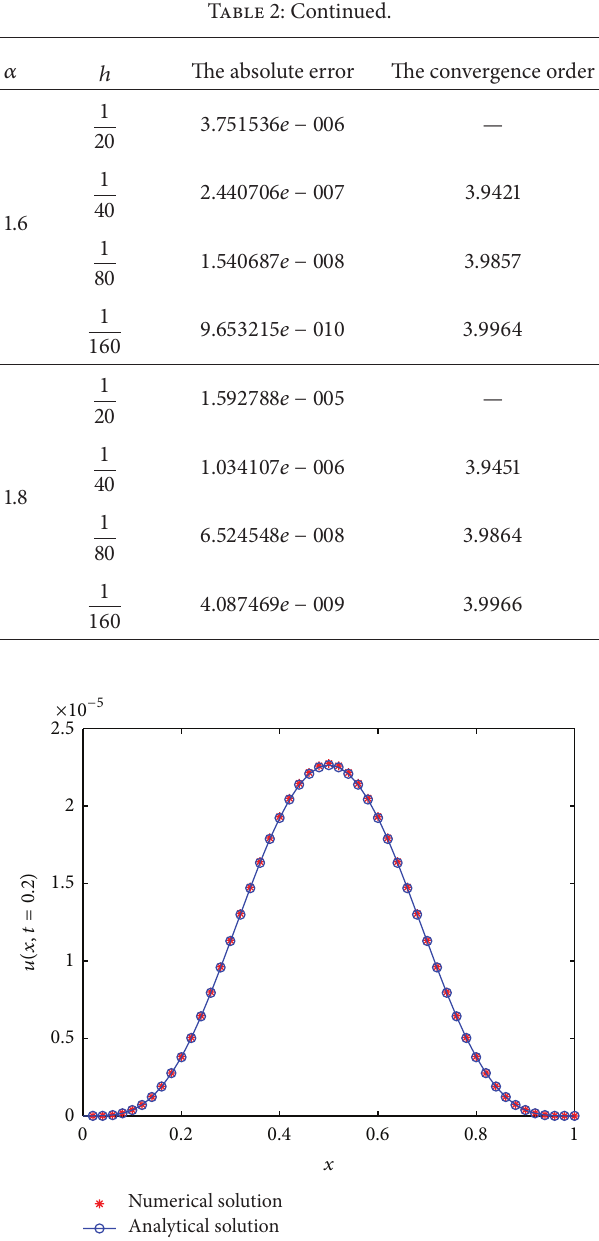
Figure 1: Comparison between the analytical solution and the numerical solution at 𝑡 = 0.2 with 𝛼 = 1.1 in Example 3 (𝜏 = 1/50, ℎ = 1/50)